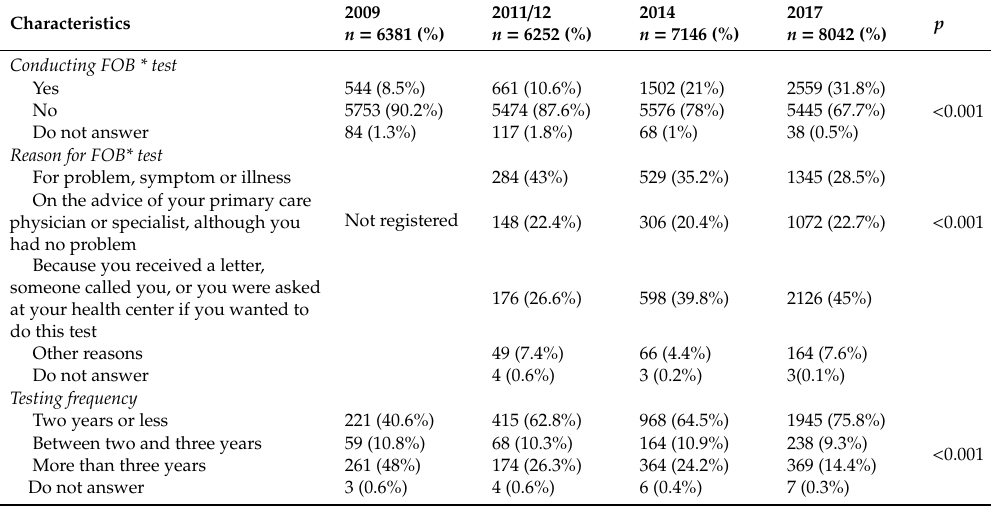
Table 2. Fecal occult blood testing of Spanish people between 50–70 years ( n = 27,821) in the period